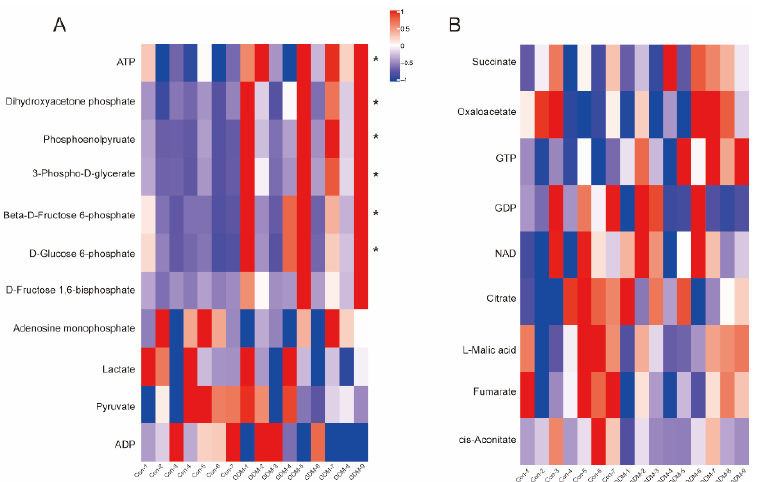
Figure 7. Placental glycolysis and the TCA cycle were compromised under hyperglycemic conditions. ( A , B ): Heatmaps of the detected intermediates in glycolysis and the TCA cycle, respectively. ATP, adenosine triphosphate; ADP, adenosine diphosphate; GTP, guanosine triphosphate; GDP, guanosine diphosphate; NAD, nicotinamide adenine dinucleotide. * p < 0.05